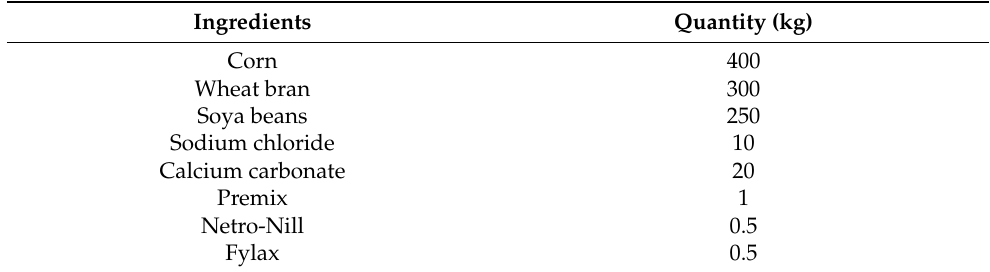
Table 1. Composition of the concentrate feed mixture (CFM) fed to growing Barki and Aboudeleik